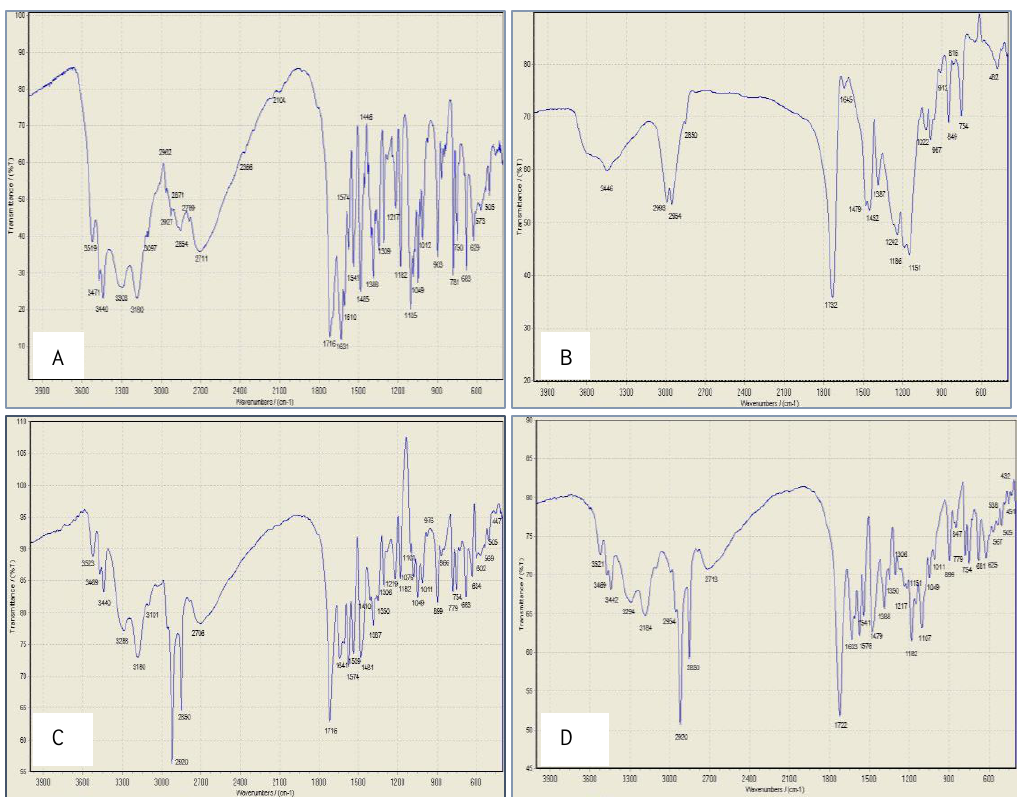
Figure (5): The FTIR spectrum of [A]pure ACV [B] eudragit RS100 [C] physical mixture [D] microsponge F2